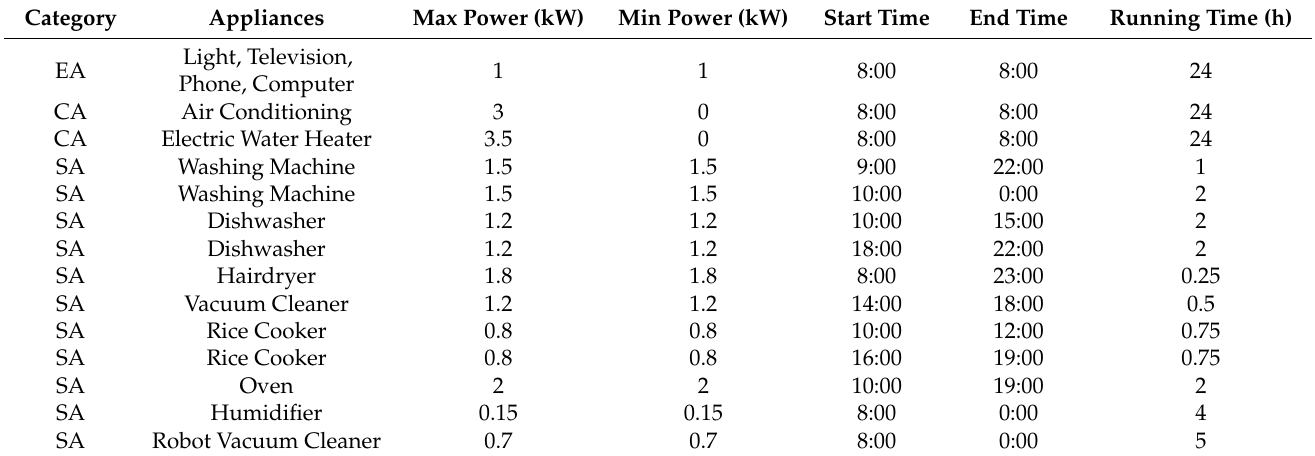
Table 1. Home appliance